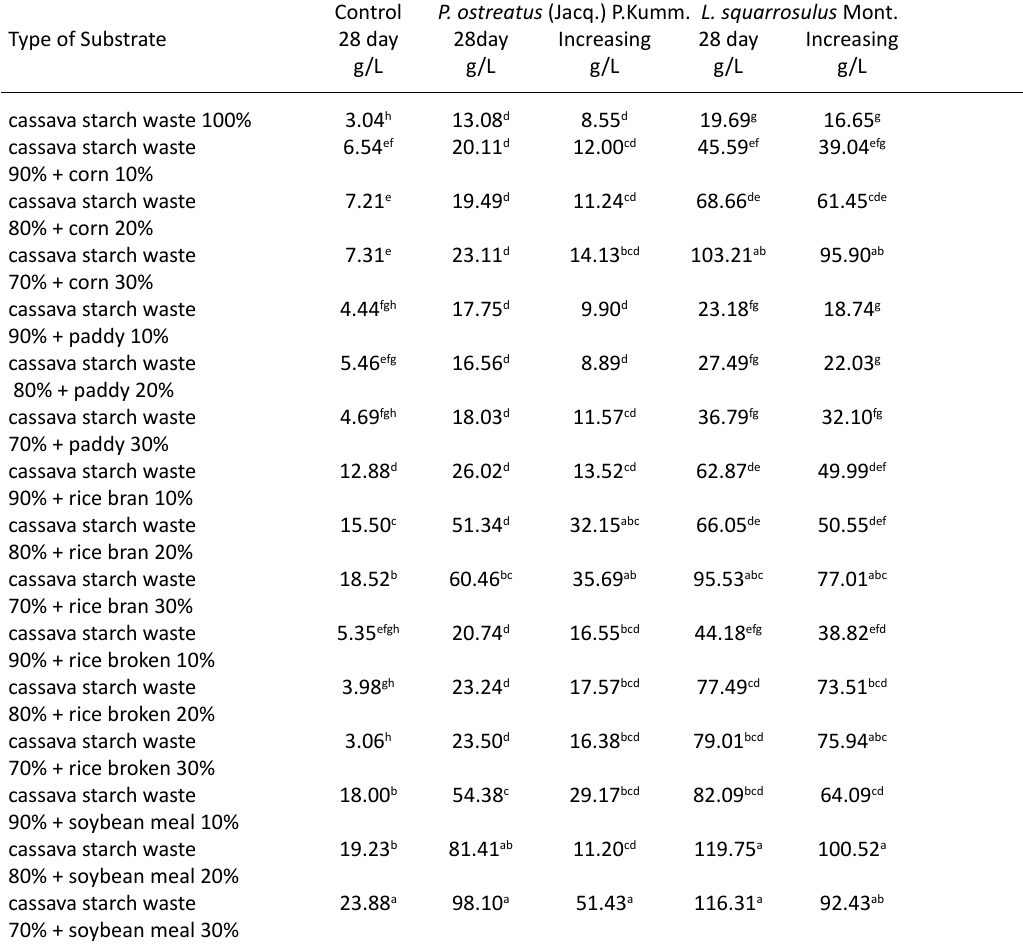
Table 6. Effect of P. ostreatus (Jacq.) P.Kumm. and L. squarrosulus Mont. on protein content at 28 day (g/L)